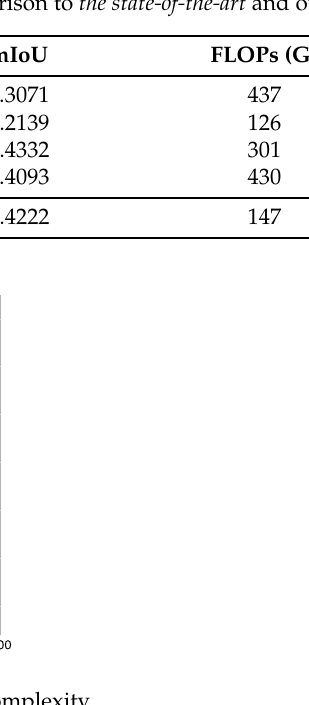
Figure 5. Comparison of performance and computational complexity.